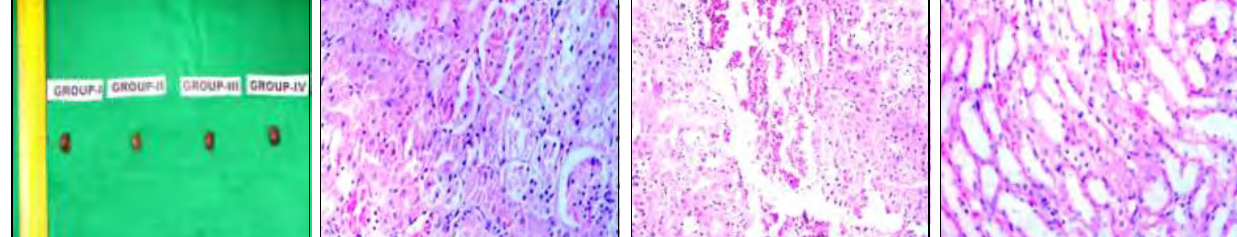
Fig. 4 Photomicrograph of kidney showing marked tubular dilation (Group 2, day 14). H&E X100